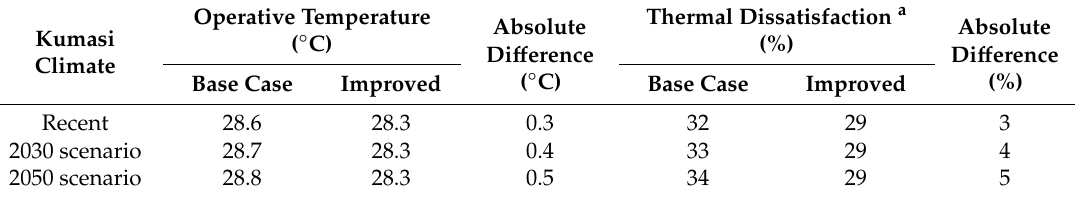
Table 13. Indoor comfort and environmental performances of the building as-built and with improvement strategies.